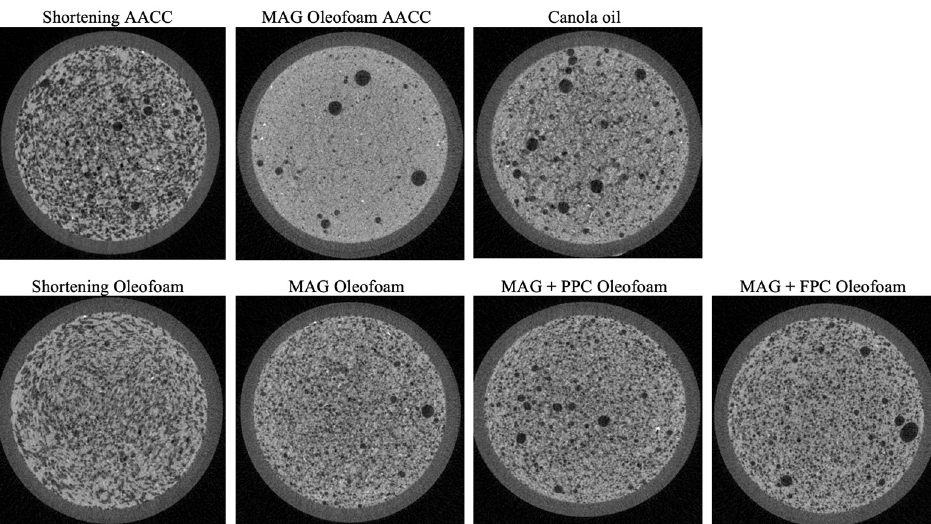
Figure 5. X-ray microtomography images of different cake batters. The names of the batters are shown on the top of each image. Shortening AACC and MAG oleofoam AACC batters were prepared using the AACC method, and the rest of the batters were prepared using the new lab-developed method. MAG, monoacylglycerols; PPC, pea protein concentrate-stabilized foam; FPC, faba bean protein concentrate-stabilized foam.